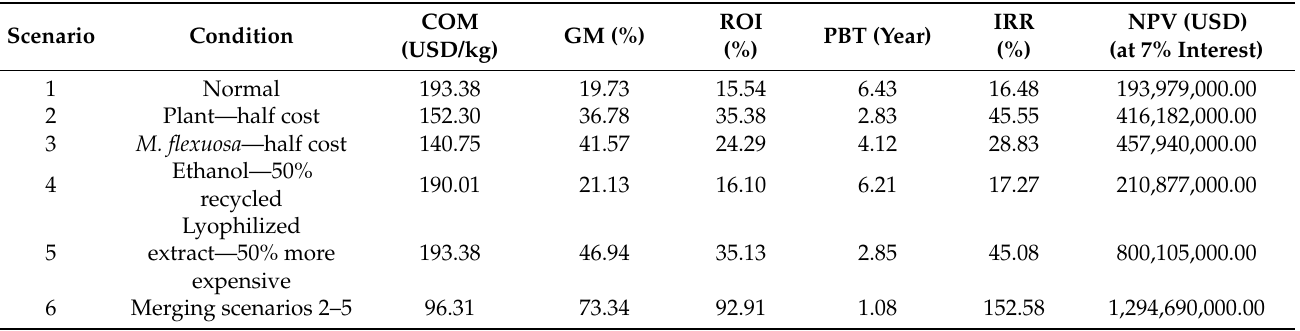
Table 7. Project indices of the sequential two-stage process using supercritical and conventional solvent extraction